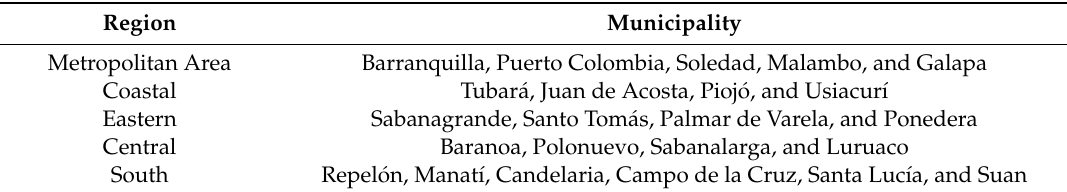
Table 1. Political–administrative regions and municipalities within the department of Atl á ntico.